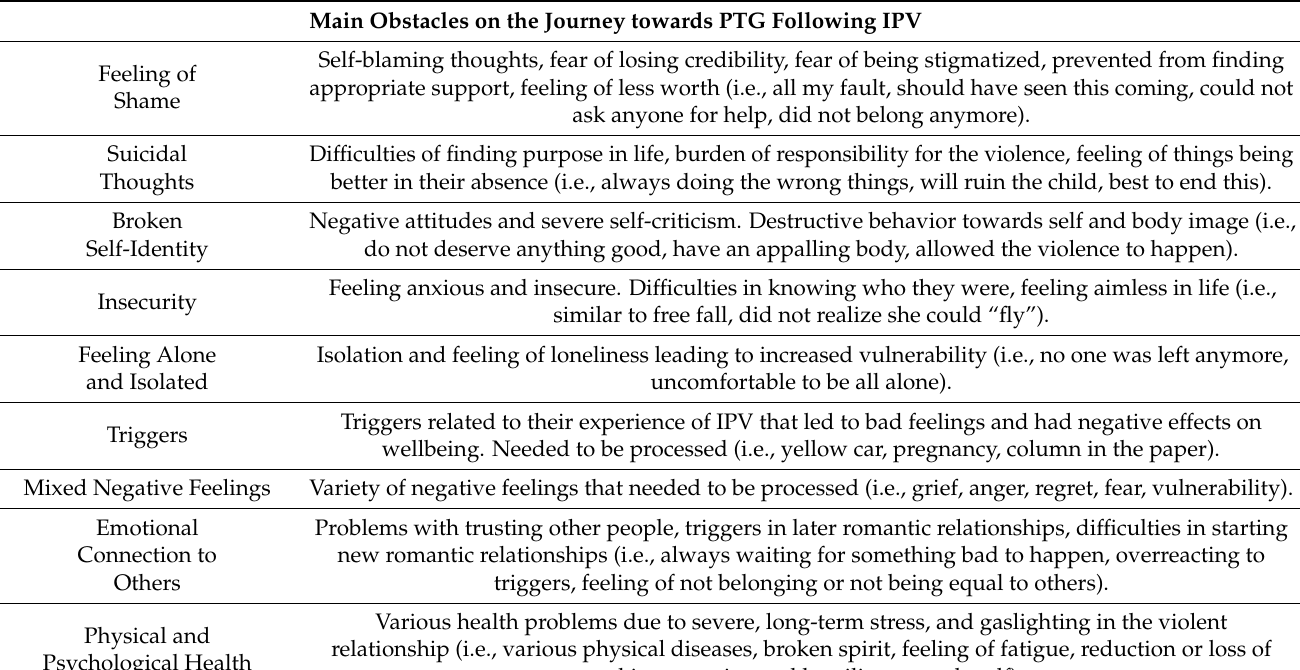
Table 4. Overview of the fourteen main obstacles on the participants’ journey towards PTG follow- ing